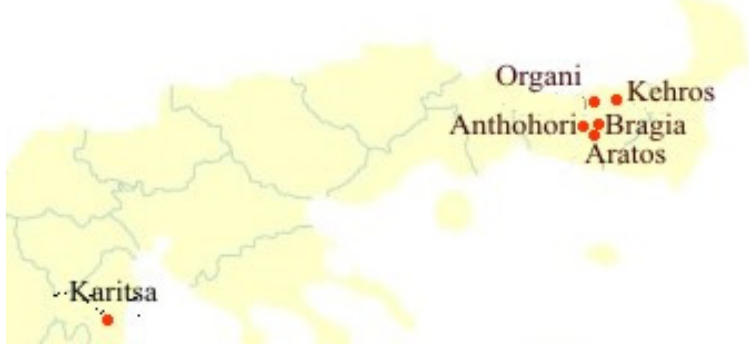
Figure 1. The geographic distribution of the studied populations.